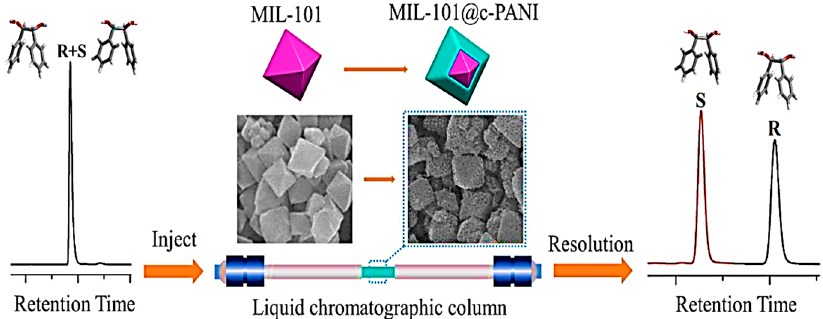
Figure 15. HPLC enantioseparation based on the application of chiral polyaniline-modified MOF core-shell composite MIL-101@c-PANI. Reprinted (adapted) with permission from [124].